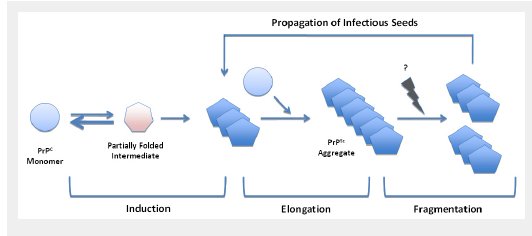
Schematic model of seeded polymerisation, which involves the interaction between a prion seed with PrP C . Partial unfolding of PrP C may promote induction and propagation of PrP C to PrP Sc . It is unknown how prion aggregates or fibrils are fragmented into reactive infectious seeds.